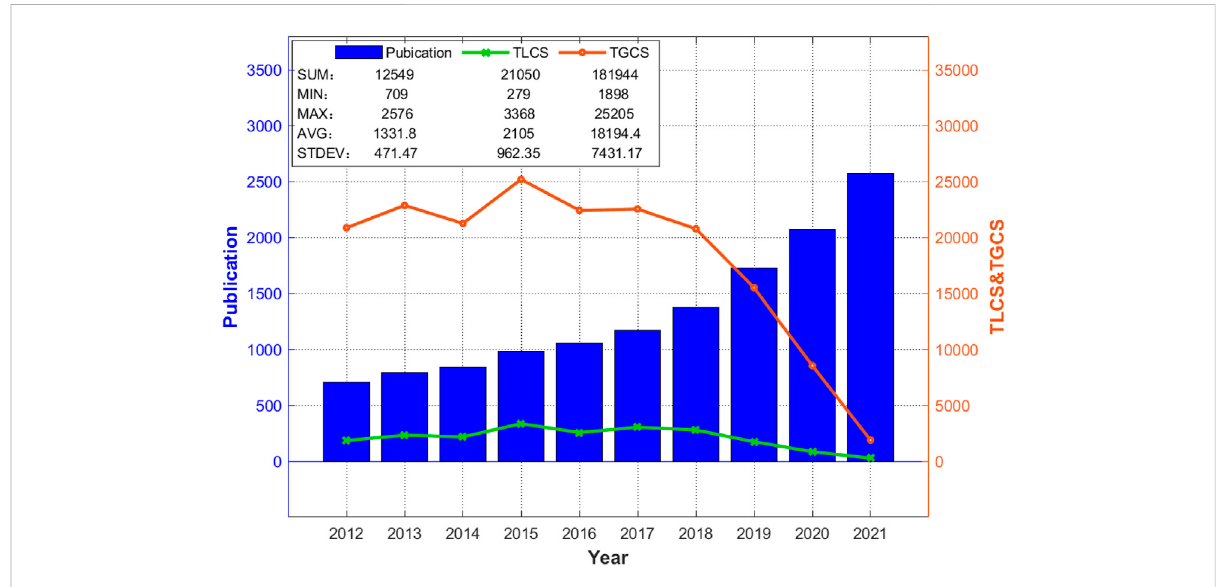
FIGURE 2 Temporal distribution of the output of remote sensing research from 2012 to 2021.